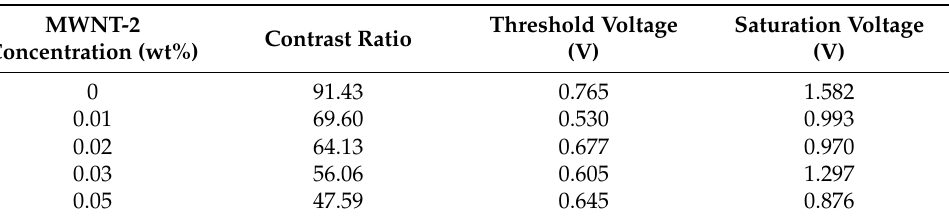
Table 2. The contrast ratio, threshold voltage, and saturation voltage in different concentrations of MWNT-2-doped TN cells.